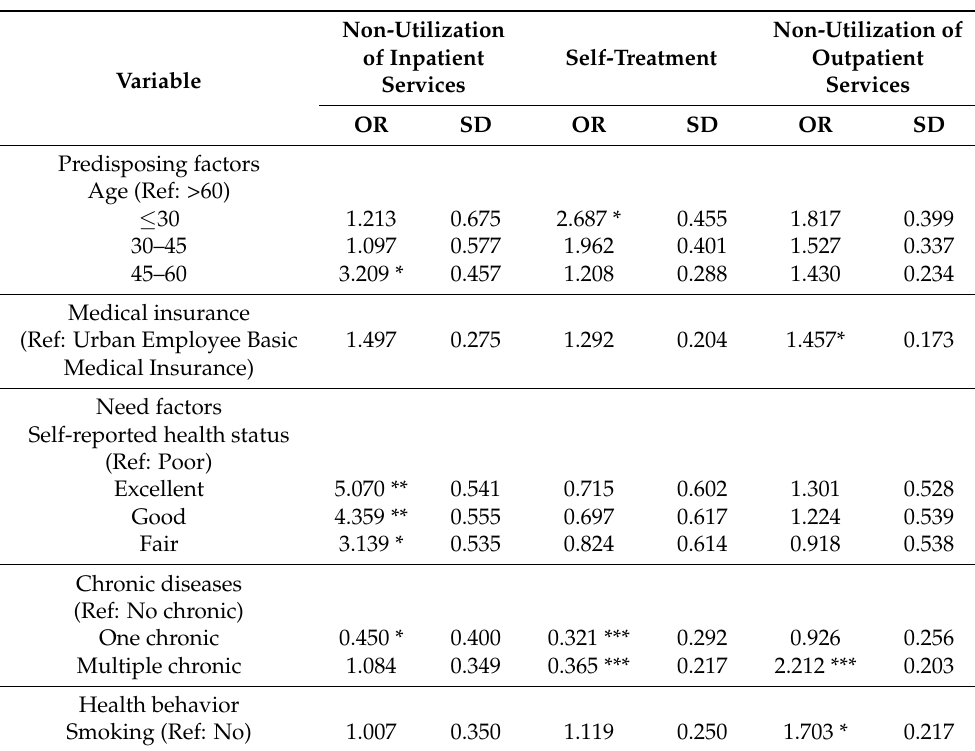
Table 4. Logistic regression of unmet healthcare needs among unwell migrants in Shanghai.